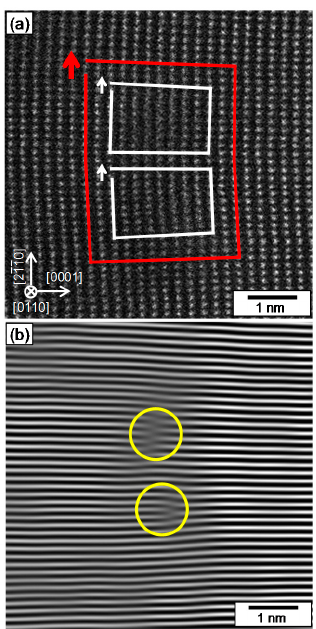
Figure 4. ( a ) A typical HAADF-STEM image taken from one of the contrasts on the image of Figure 3. Burgers circuit for a basal edge dislocation is drawn by red color line while Burgers circuits for two partial dislocations are drawn by white color lines. ( b ) The inverse Fast-Fourier-Transformed (FFT) image reconstructed from a mask-applied FFT image of ( a ). Yellow circles indicate the positions of cores of partial dislocations.